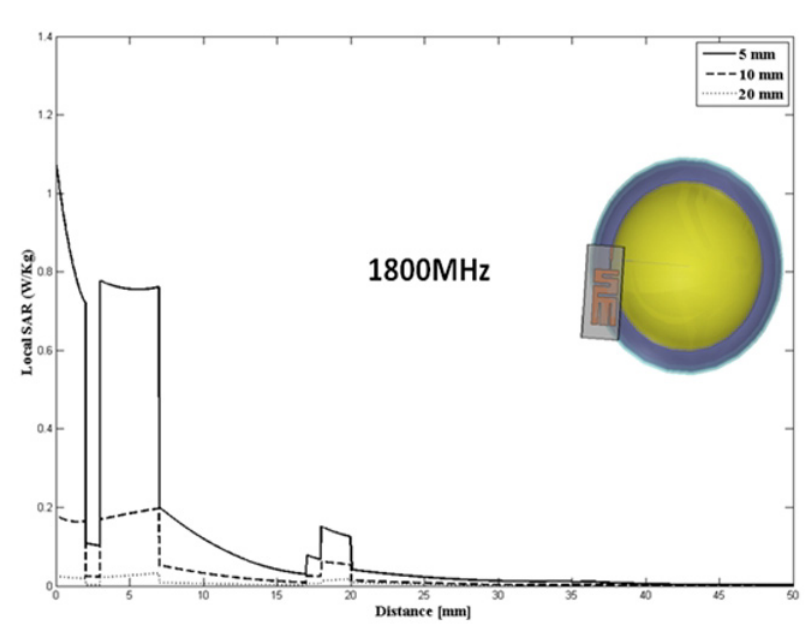
Figure 6. Local SAR variation at different patch antenna-head distances at 1800 MHz.